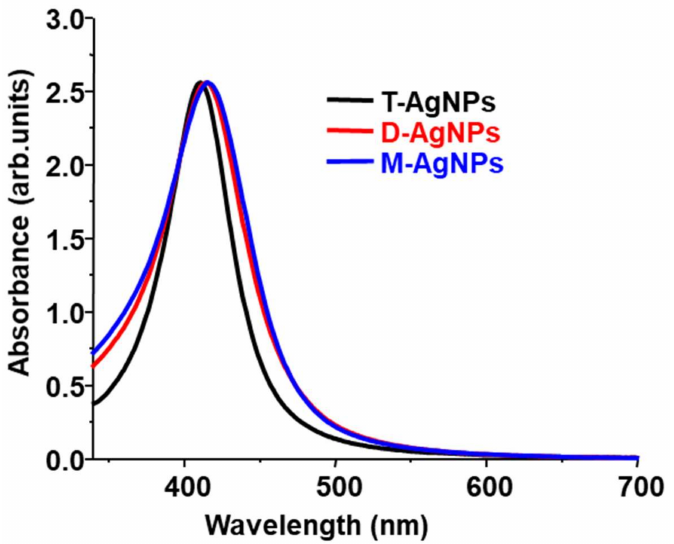
Figure 6. UV-Vis absorption spectra of T-AgNPs, D-AgNPs, and M-AgNPs prepared at 120 ◦